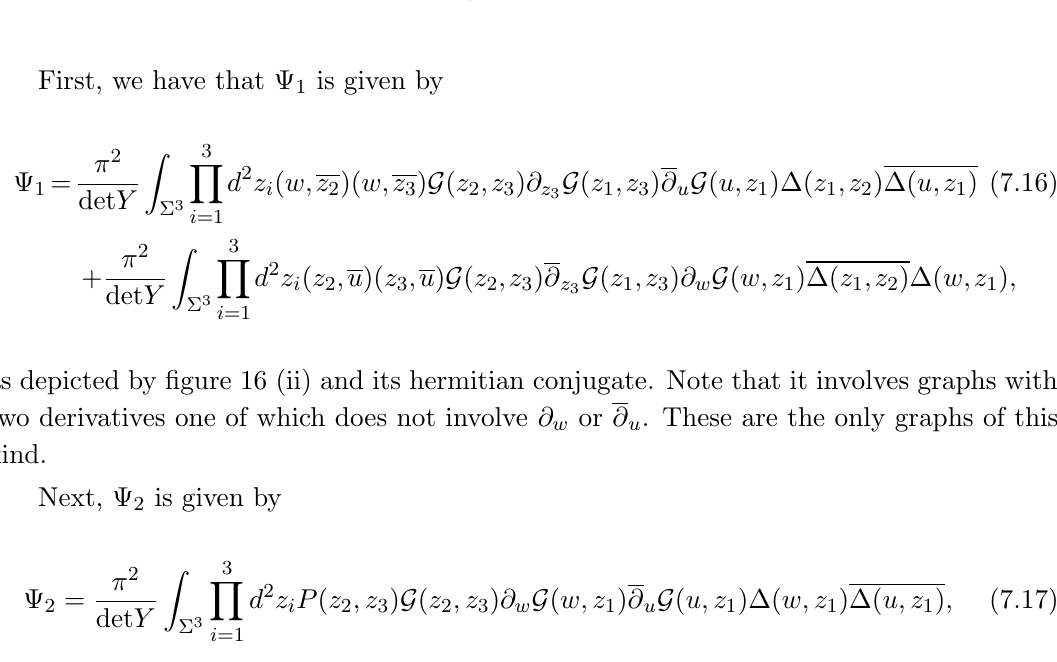
Figure 16 . Skeleton graphs for various